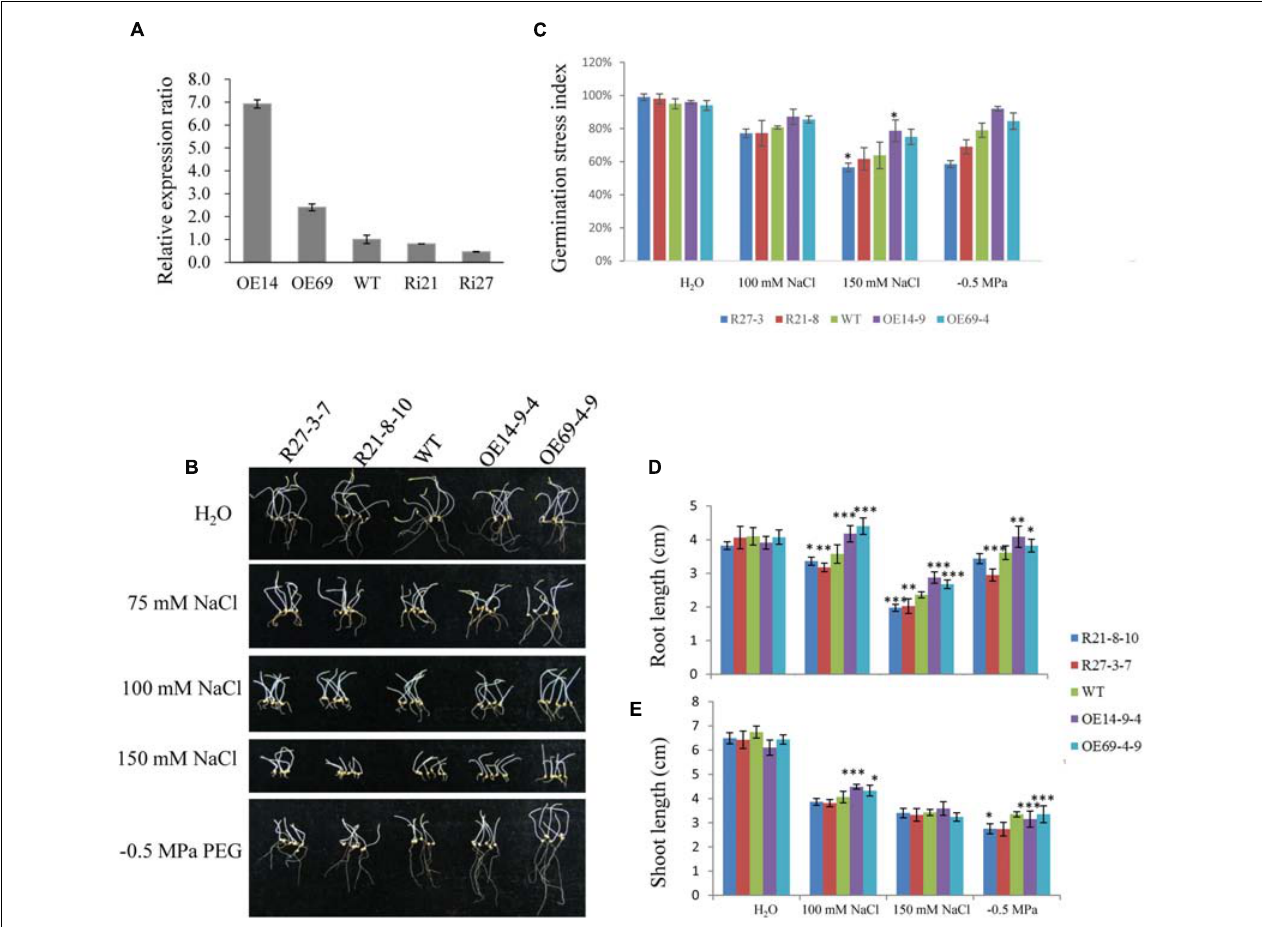
FIGURE 7 | Effects of NaCl and PEG stresses on foxtail millet germination rates. Relative expression levels of SiLTP in T1 transgenic foxtail millet and WT plants as determined by qPCR (A) . Seeds of WT and transgenic lines were germinated and grown for 8 days in water independently supplemented with 0 (control), 100 mM, 150 mM NaCl, or − 0.5 MPa PEG (B) . The corresponding seed germination rates (C) , root lengths (D) , and shoot lengths (E) were compared. ∗ , ∗∗ , and ∗∗∗ indicate statistically significant differences at P < 0.05, P < 0.01, and P < 0.001 (Student’s t -test),